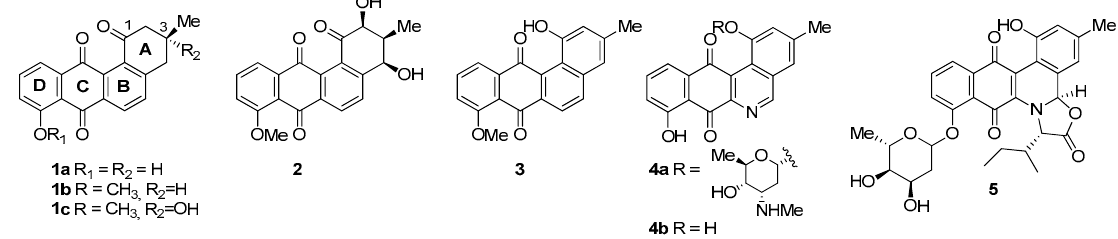
Figure 1. Some examples of natural angucyclinones.